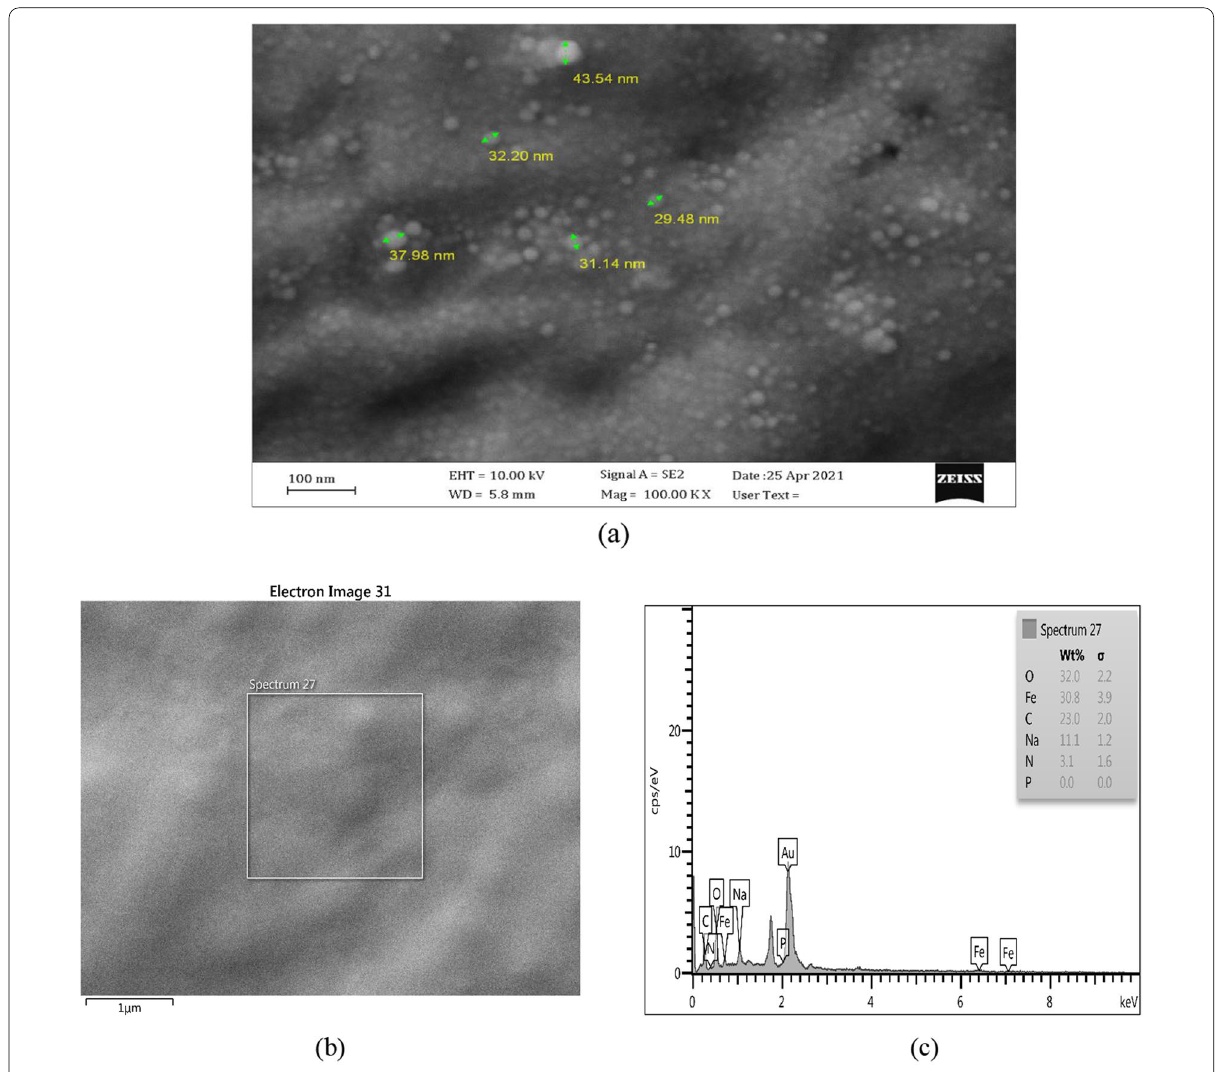
Fig. 2 a Imaging using Field-Emission Scanning Electron Microscopy (FESEM), b , c element mapping using